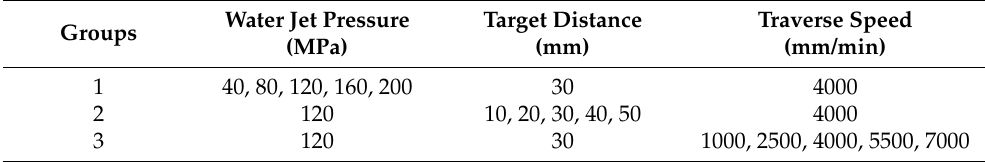
Table 2. The levels of factors in single-factor stem node cutting tests.